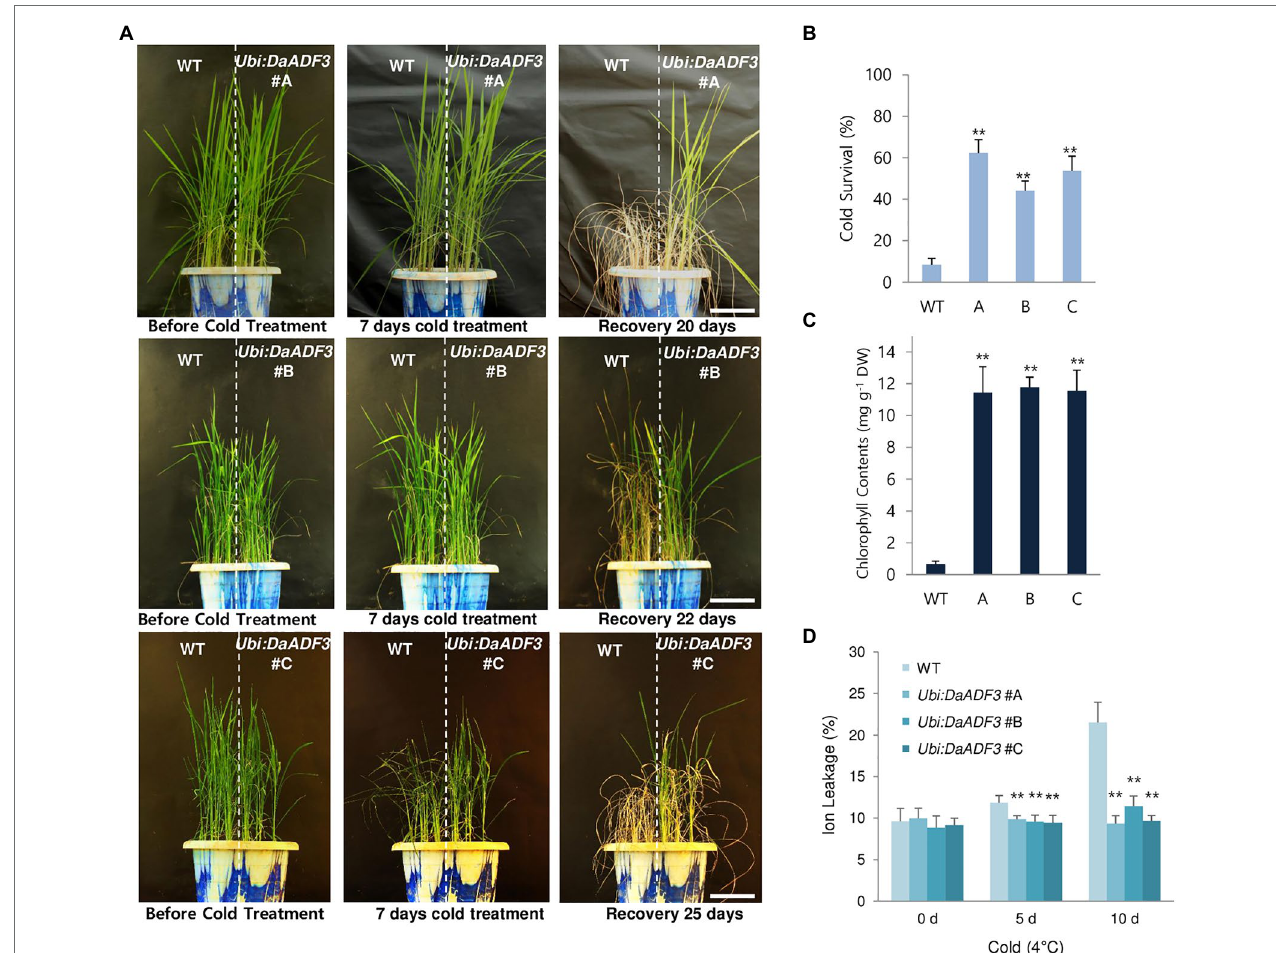
FIGURE 6 | Increased tolerance of DaADF3 -overexpressing transgenic rice plants in response to cold stress. (A) Cold stress phenotypes of WT and Ubi:DaADF3 transgenic rice plants. Light-grown, 5-week-old WT and T3 Ubi:DaADF3 (lines #A, #B, and #C) rice plants were transferred to a cold room at 4 ° C for 8 days, after which the plants recovered at 28 ° C for 20–25 days. Bars = 15 cm. (B) Survival rates of WT and Ubi:DaADF3 plants in response to cold stress. Data are means ± SD ( n ≥ 6 biologically independent experiments; > 30 plants per assay, ** p < 0.01, Student’s t -test). (C) Total leaf chlorophyll content of WT and Ubi:DaADF3 plants after cold treatment. The amounts of leaf chlorophyll (chlorophyll a + chlorophyll b) were determined 1 month after recovery from cold stress. Data are means ± SD (n ≥ 3 biologically independent experiments; > 10 plants per assay, **p < 0.01, Student’s t -test). (D) Electrolyte leakage analysis of WT and Ubi:DaADF3 plants before and after cold stress. Electrolyte leakage analysis was conducted using 8-day-old WT and Ubi:DaADF3 (independent lines #A, #B and #C) seedlings that were incubated at 4 ° C for 0, 5, and 10 days. Data are means ± SD ( n = 3 biologically independent experiments; > 12 plants per genotype per experiment, ** p < 0.01, Student’s t